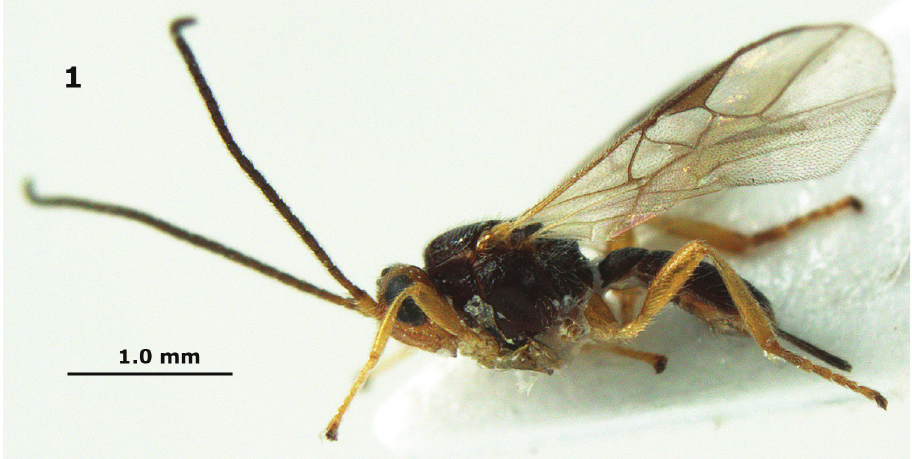
Figure 1. Orientopius punctatus sp. n., female, holotype. Habitus podeum distinctly in front of middle of propodeum; hind basitarsus about 3.7 times